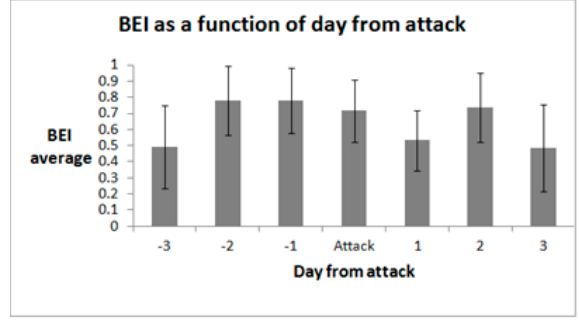
Figure 4. Dynamics of BEI by day from attack. Only non-overlapping samples were included for analysis (e.g., if a sample was taken up to two days after one attack and within two days of the next attack, it was excluded from analysis).